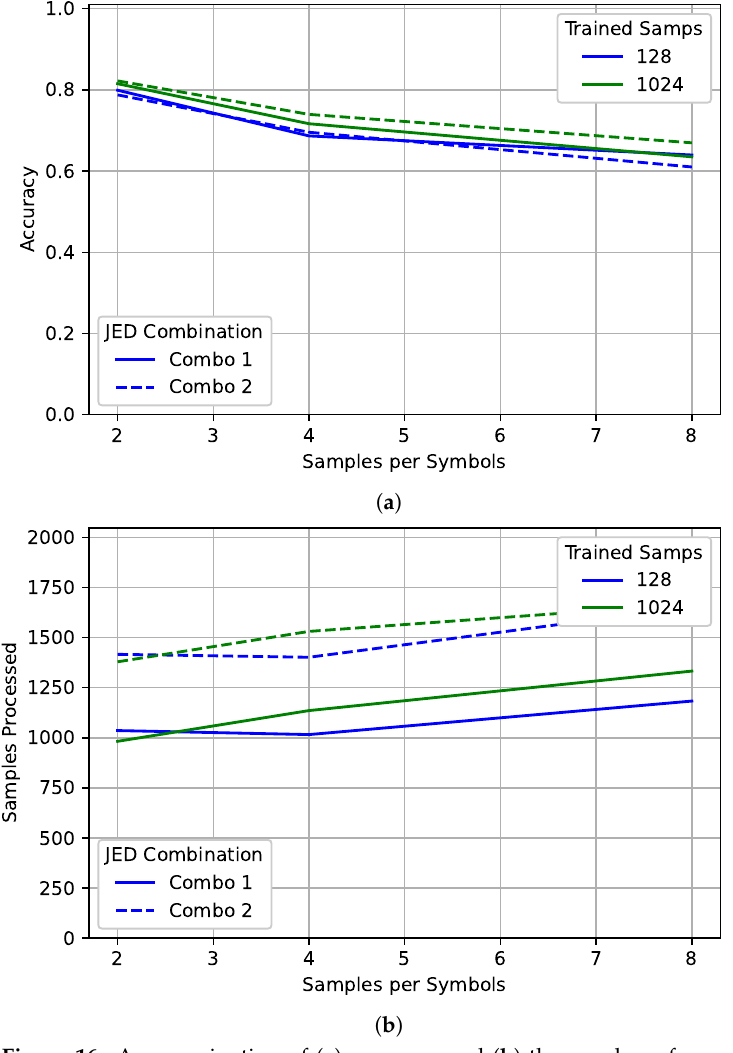
Figure 16. An examination of ( a ) accuracy and ( b ) the number of samples processed of JED for different oversampling rates. The best model for 128 and 1024 are each shown after processing with two different JED